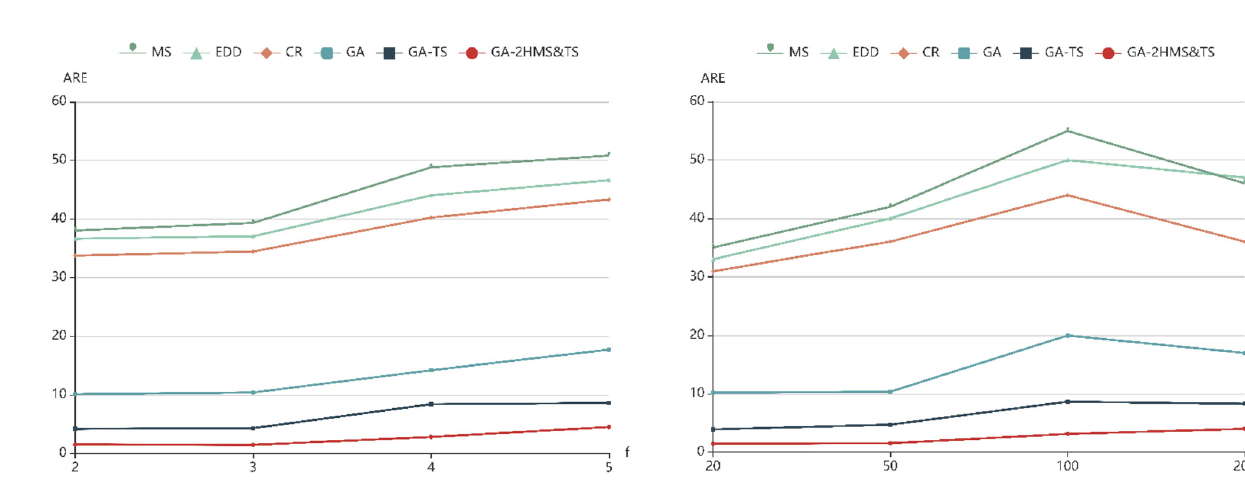
Fig. 4 Boxplot graphs of six algorithms